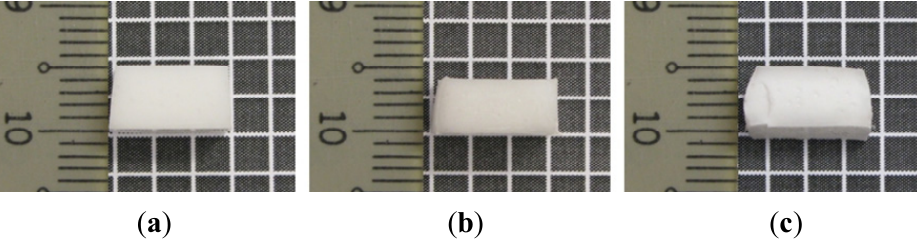
Figure 22. Impact-induced shape recovery in silicone–PW hybrid. ( a ) original shape; ( b ) after programming; and ( c ) after being hammered